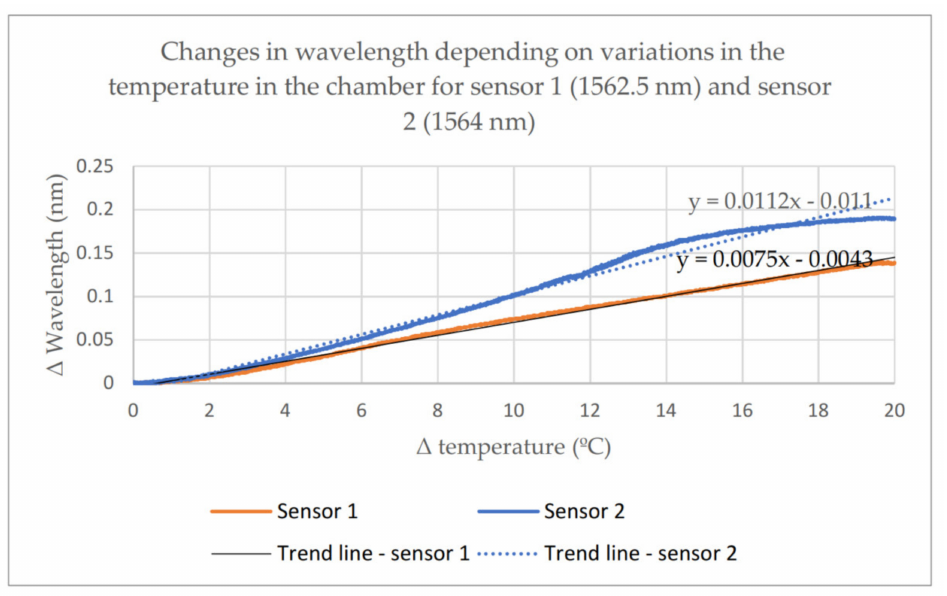
Figure 5. Changes in wavelength depending on temperature changes—sensor 1 and sensor